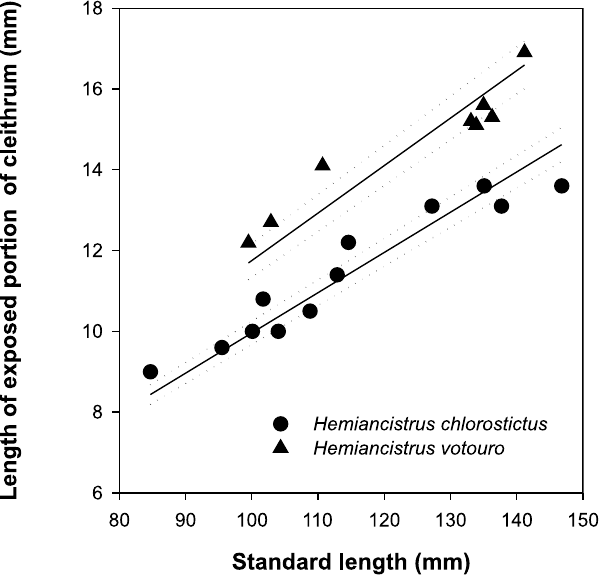
Fig. 3. Scatter plot and regression line of length of exposed portion of cleithrum as a function of standard length in Hemiancistrus votouro and H. chlorostictus .